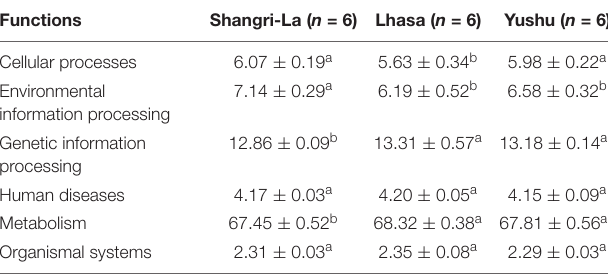
TABLE 3 | Percentage composition of other functional genes of the microbiota of yaks from different regions.